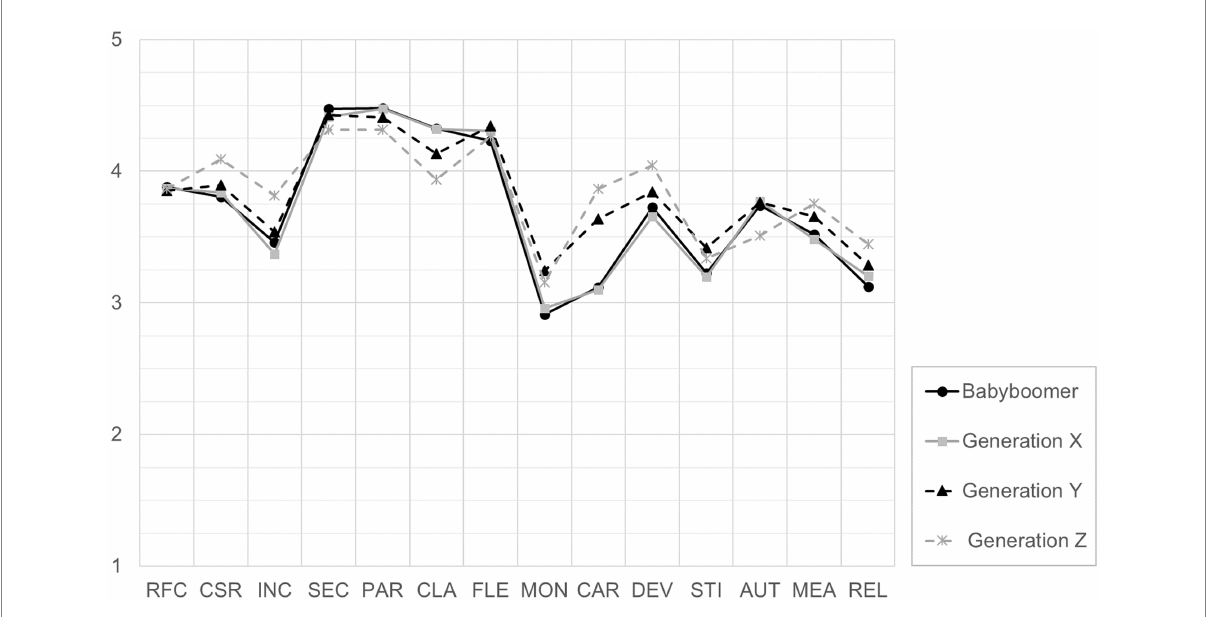
FIGURE 1 Mean Work Values of the Generations. RFC = Readiness for Change, CSR = Corporate Social Responsibility, INC = Inclusion, SEC = Security, PAR = Participation, CLA = Clarity, FLE = Flexibility, MON = Money, CAR = Career, DEV = Development, STI = Stimulation, AUT = Autonomy, MEA = Meaning, REL =